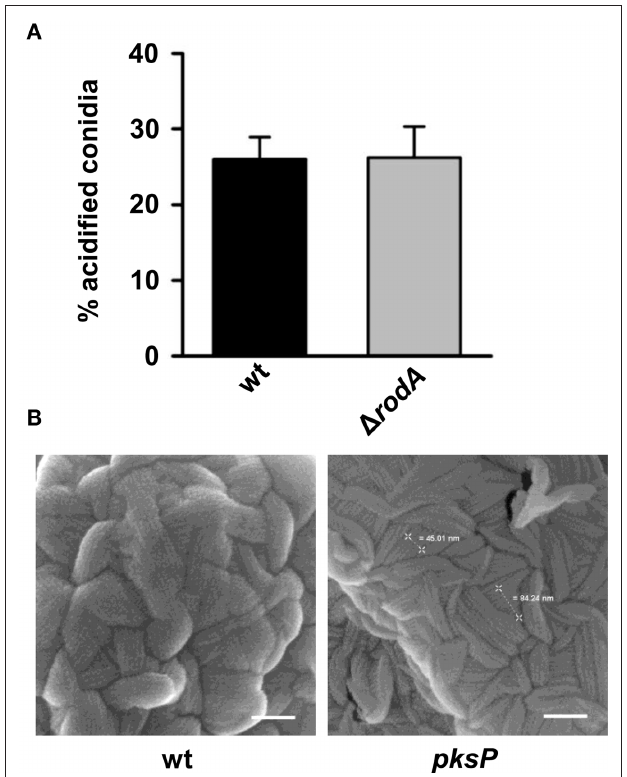
FiguRe 3 | influence of A. fumigatus wild-type-derived melanin ghosts on phagolysosomal acidification. (A) Percentage of intracellular conidia residing in acidified phagolysosomes after ingestion by MH-S cells. Latex beads were used as a positive control. Values represent the mean + SD of three experiments. (B) Representative micrographs showing colocalization of melanin ghosts, stained prior to phagocytosis with biotinylated anti-melanin camelid antibody and Cy5.5 conjugated streptavidin (red), with acidified compartments visualized by LysoTracker labeling (green). Size bar, 2 μm.